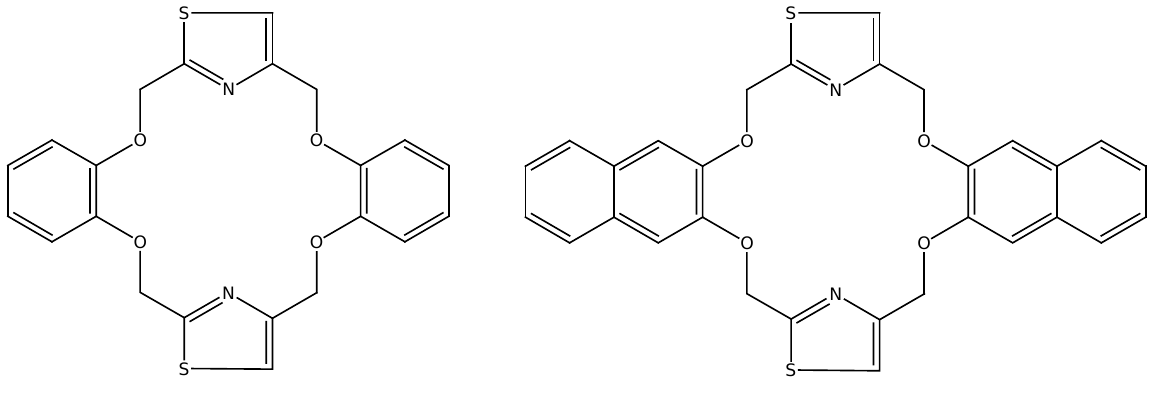
Figure 36. Thiazole-containing naphtho-crown